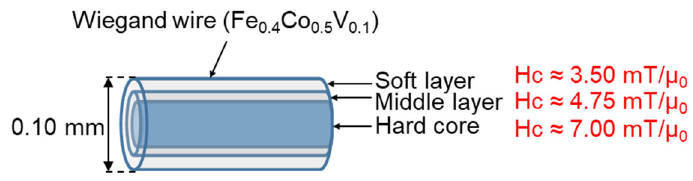
Figure 10. Magnetic structure diagram of 0.14 mm-diameter Wiegand wire.